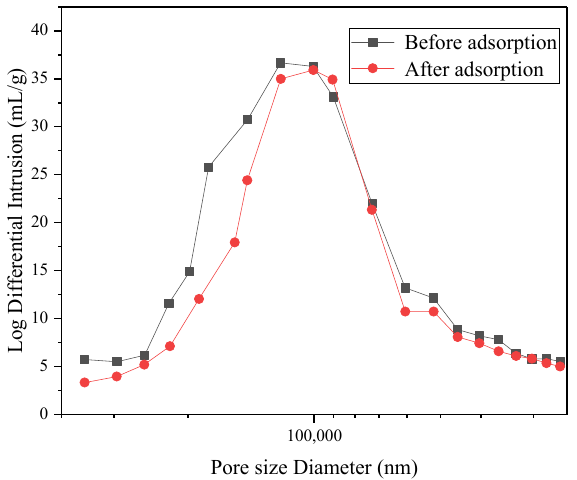
Figure 9. Log differential pore size distribution curves of CMC/P (NIPAM-co-AA) hydrogel before and after U(VI)-loading.